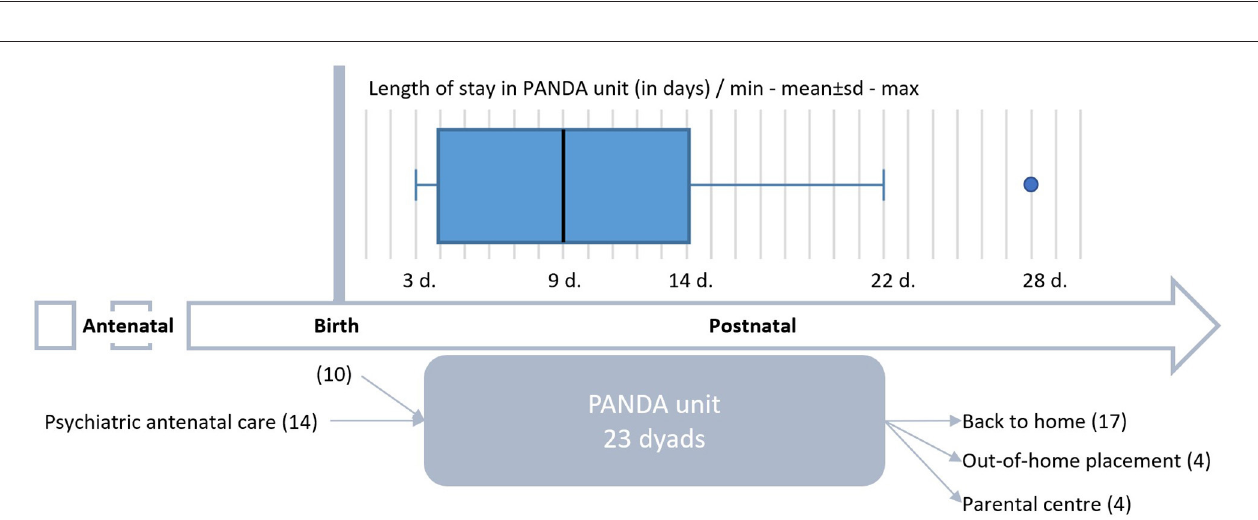
FIGURE 1 | Distribution of PANDA’s Women Diagnosis as a function of the moment of inclusion (antenatal/at birth).